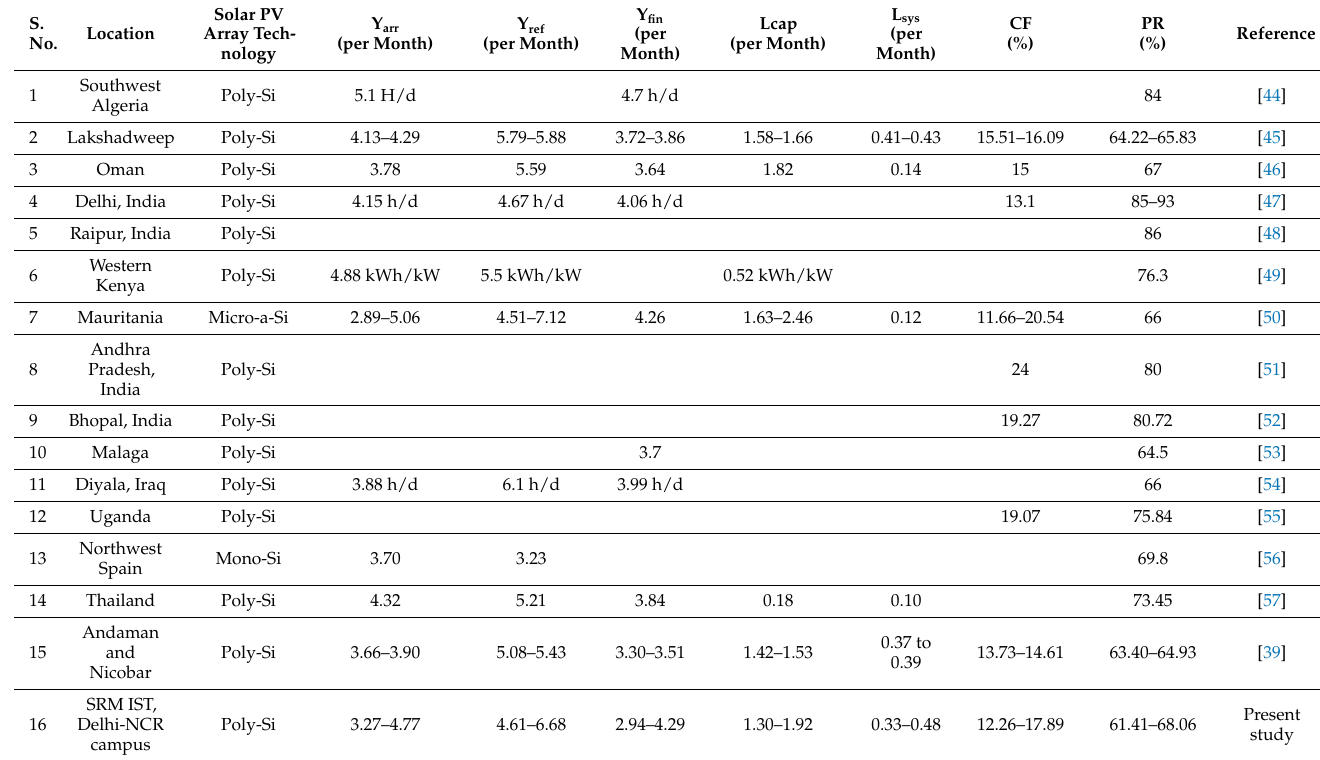
Table 8. Comparison of the performance indices of different SPV arrays installed at different locations.